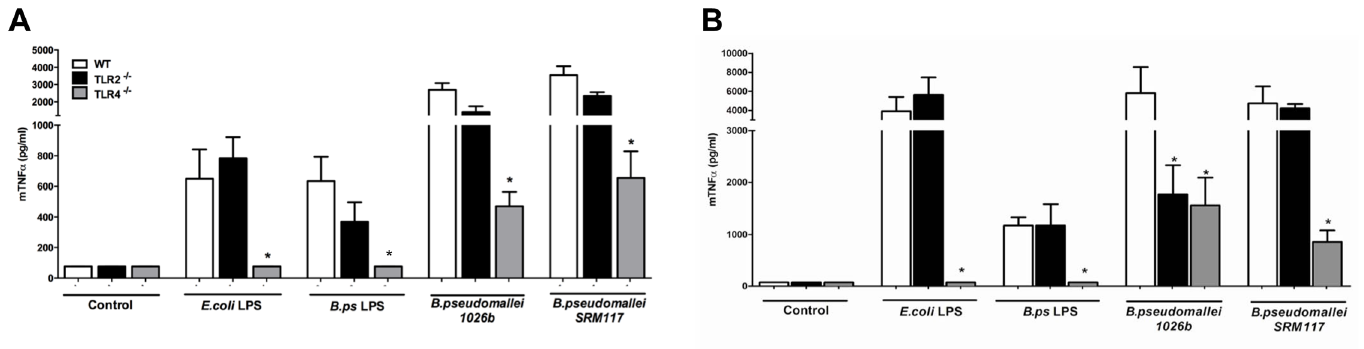
Fig 3. LPS of B . pseudomallei signals solely via murine TLR4. Murine whole blood (A) and peritoneal macrophages (B) harvested from wild-type (WT), TLR2 -/- and TLR4 -/- mice were stimulated for 24h with RPMI 1640 + 10% FCS medium, LPS of E . coli 0111:B4 (100 ng/ml), LPS of B . pseudomallei (100 ng/ ml), heat-killed B . pseudomallei 1026b (100 ng/ml), or its O-antigen lacking mutant SRM117 (both 10 7 CFU/ml) before measurement of murine TNF- α (n = 4). Following a Kruskal-Wallis test, Mann-Whitney U-tests were performed. Data are means ± SEM. Results are representative of two or three independent experiments. * P < 0.05 vs.